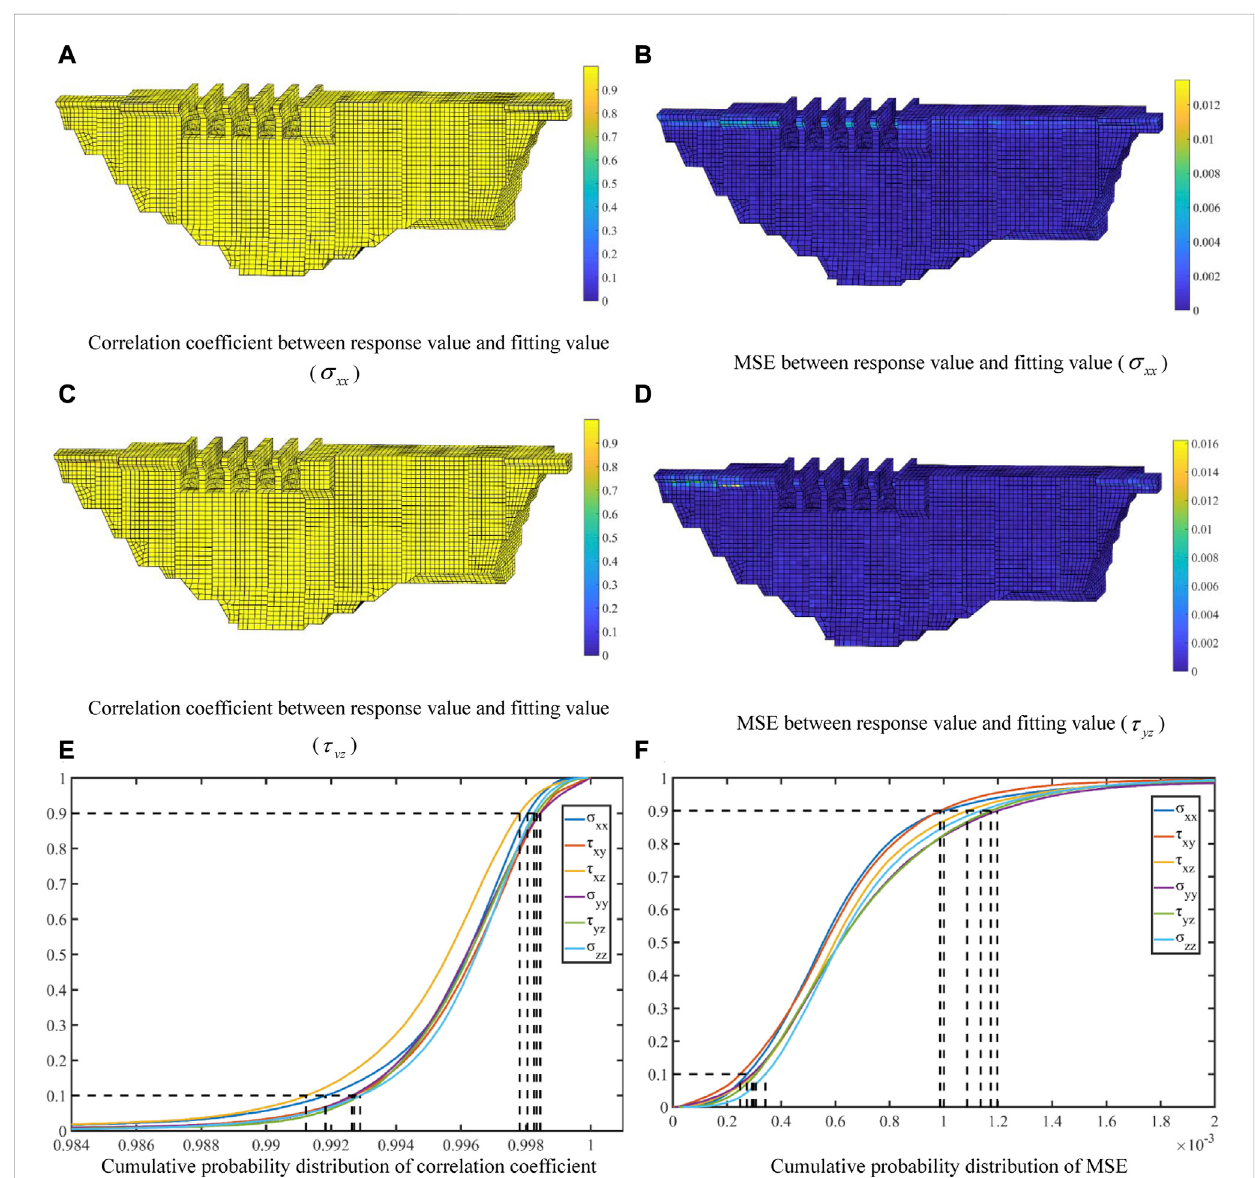
FIGURE 8 (A – D) correlation coef fi cient and MSE distribution of stress behavior surrogate model within the dam body; (E,F) cumulative probability distribution of correlation coef fi cient and MSE of stress behavior surrogate